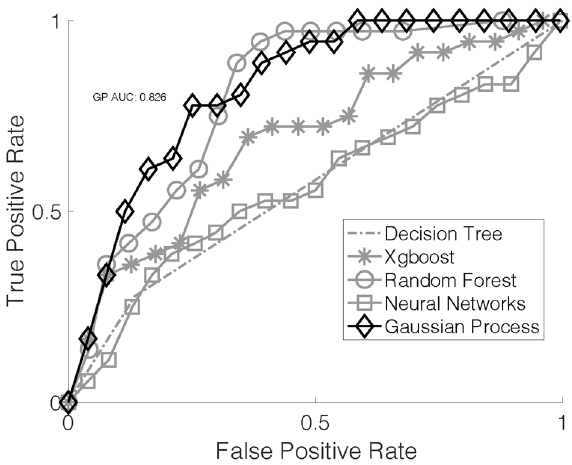
Figure 3. Area under the curve (AUC) for each machine learning (ML) classification algorithm after the validation phase. Here, the initial dataset (n = 2410) was used as the training dataset and the additional cases included after updating the database (n = 437) were used as the test dataset. Gaussian Process (GP) again showed the highest AUC and best overall